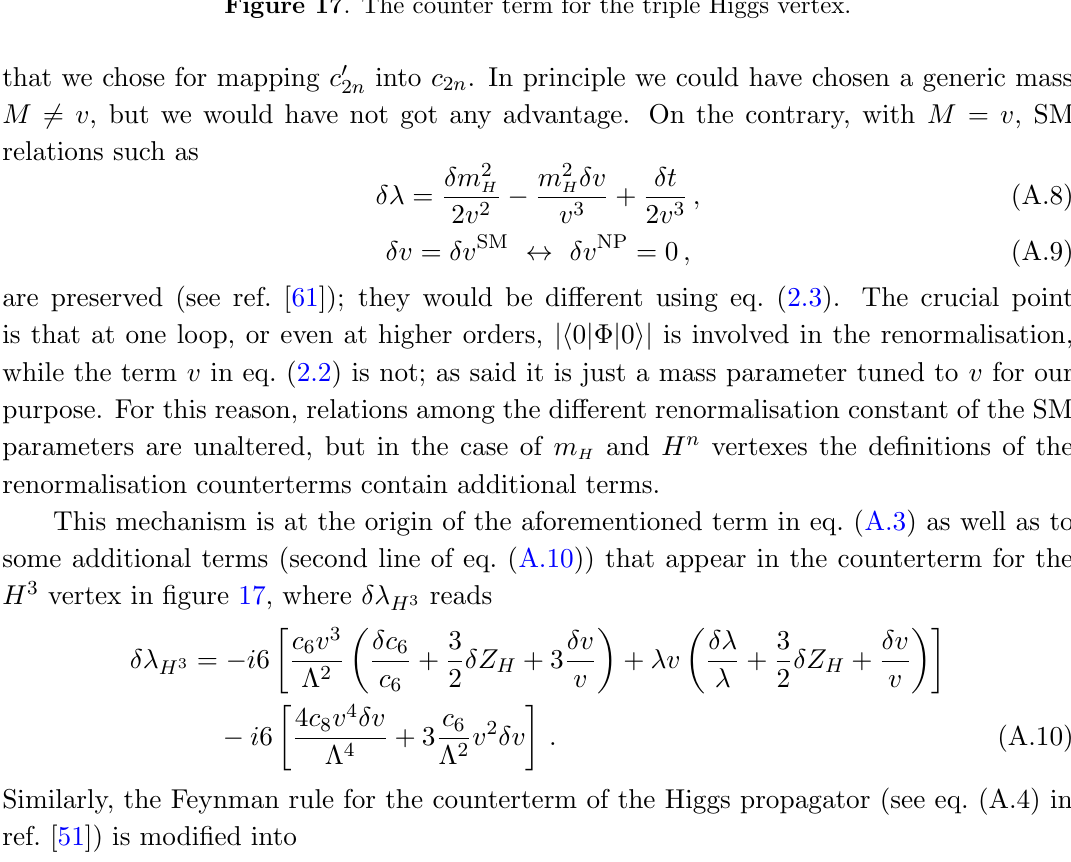
Figure 17 . The counter term for the triple Higgs